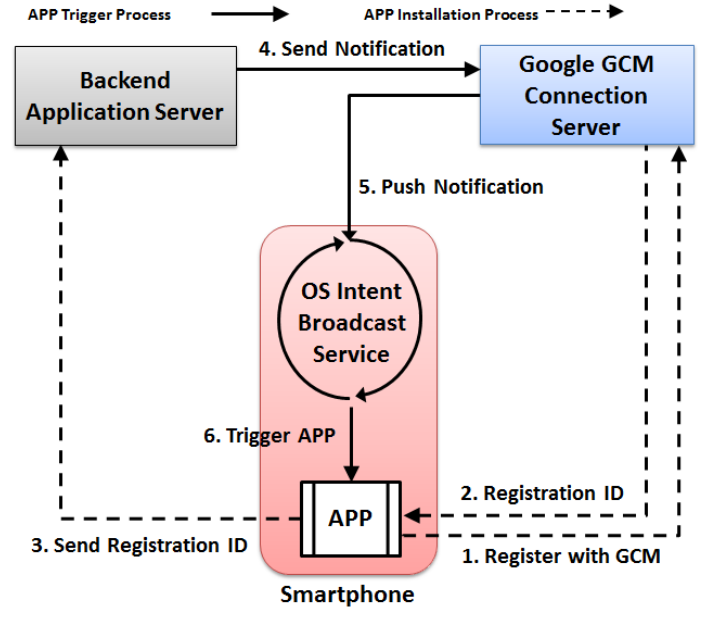
Figure 4. GCM workflow for